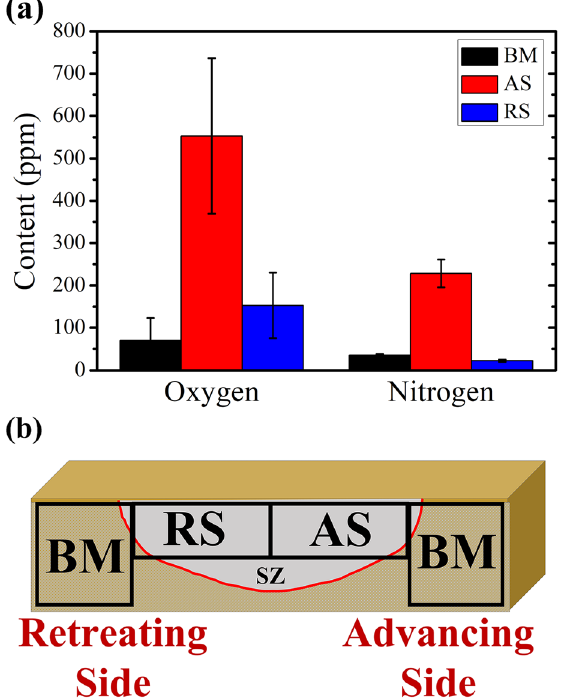
Figure 8: ( a ) The results of oxygen/nitrogen analysis of the weld at 300 rpm. ( b ) The schematic illustration of the regions analyzed. ( AS: advancing side; RS: retreating side.